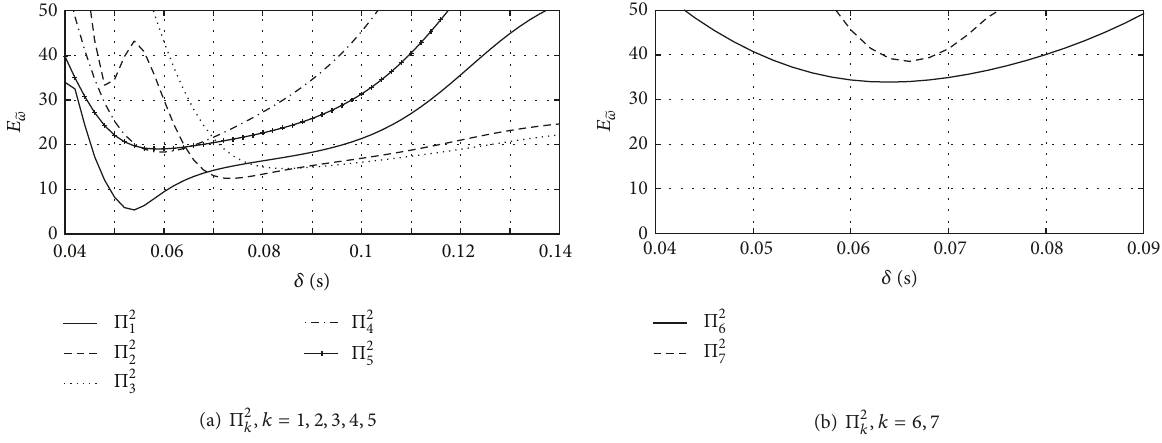
Figure 10: Function 𝐸 ̃𝜔 (𝛿) computed with two instrumented